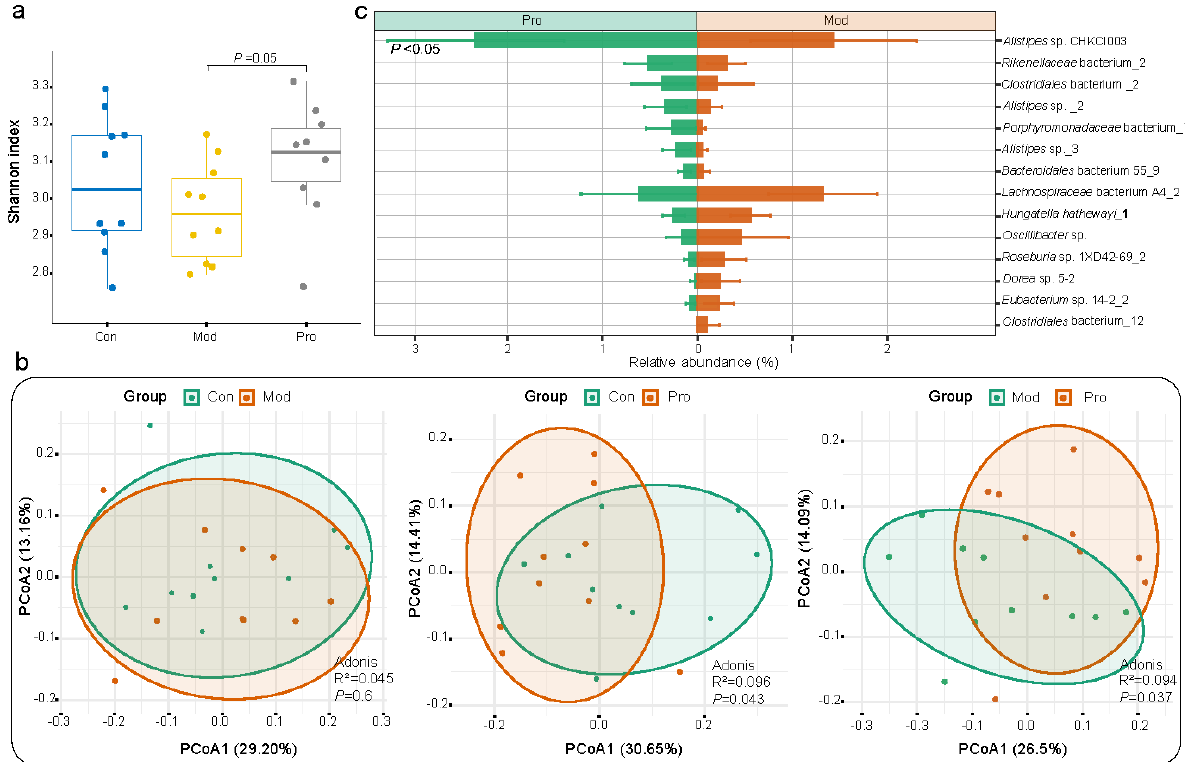
Figure 2. Microbial diversity and species − level genome bin (SGB) features of fecal metagenome dataset of mice. ( a ) Shannon diversity index of control (Con), model (Mod), and probiotic (Pro) groups at day 22. ( b ) Principal coordinates analysis (PCoA; Bray − Curtis distance) score plots of fecal microbiota. Symbols representing samples of the two groups are shown in different colors. ( c ) Responsive SGBs showing significant differential abundance between probiotic and model groups at day 22 ( p < 0.05; Wilcoxon test).